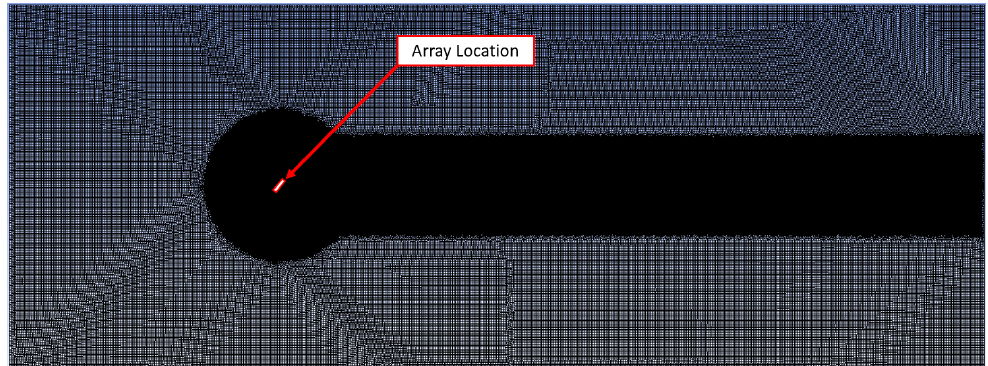
Figure 3. Mesh (Mesh 3) used in this work.